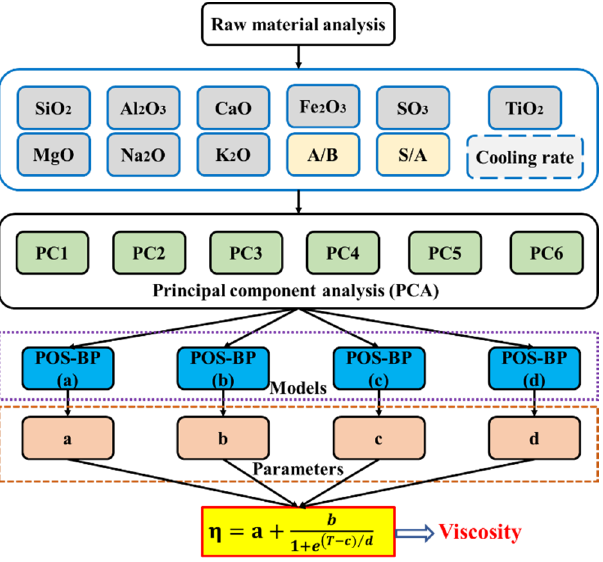
Figure 9. Indirect prediction process for glassy slag viscosity.